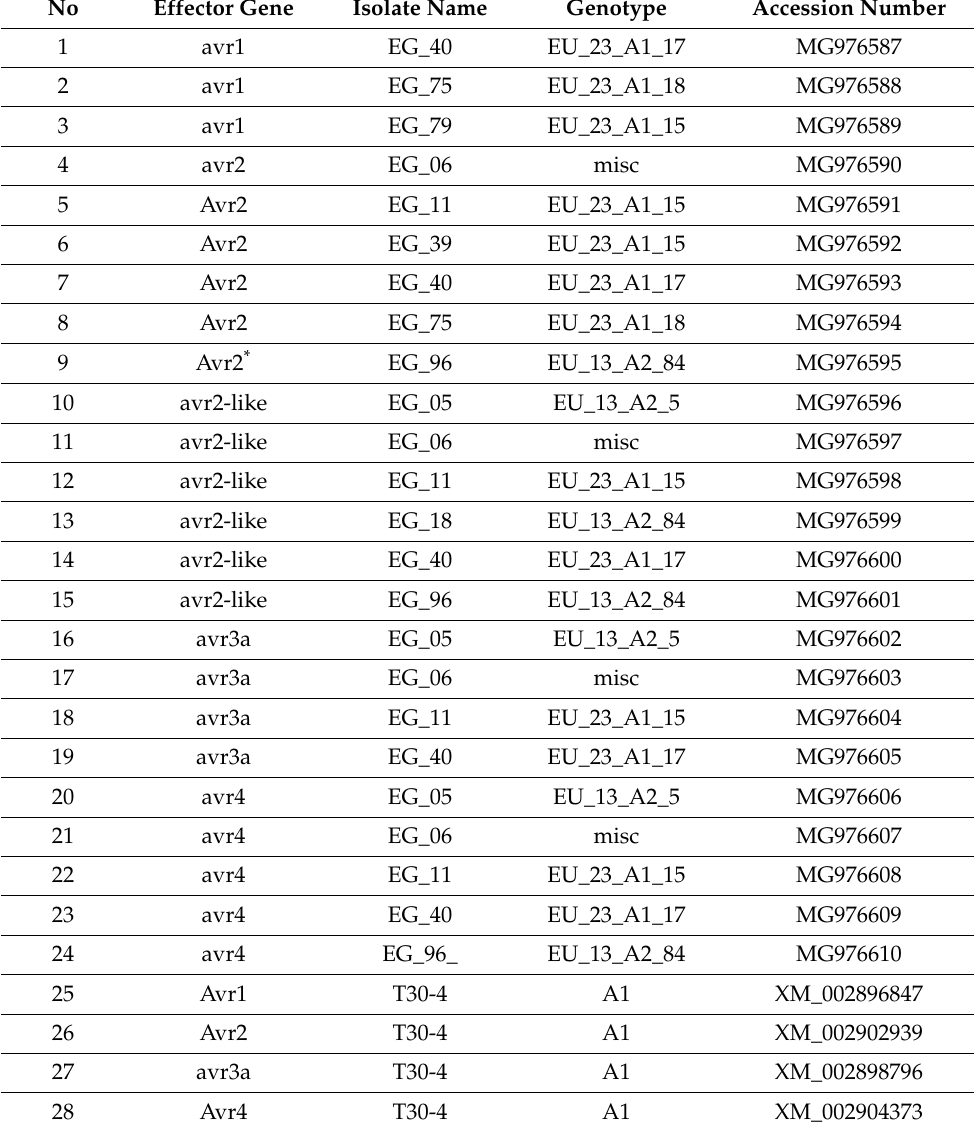
Table 5. The details of the effector genes in the current study with the reference strain T30-40, including the isolate and genotype to which they belong, as well as the accession number of effector genes submitted to